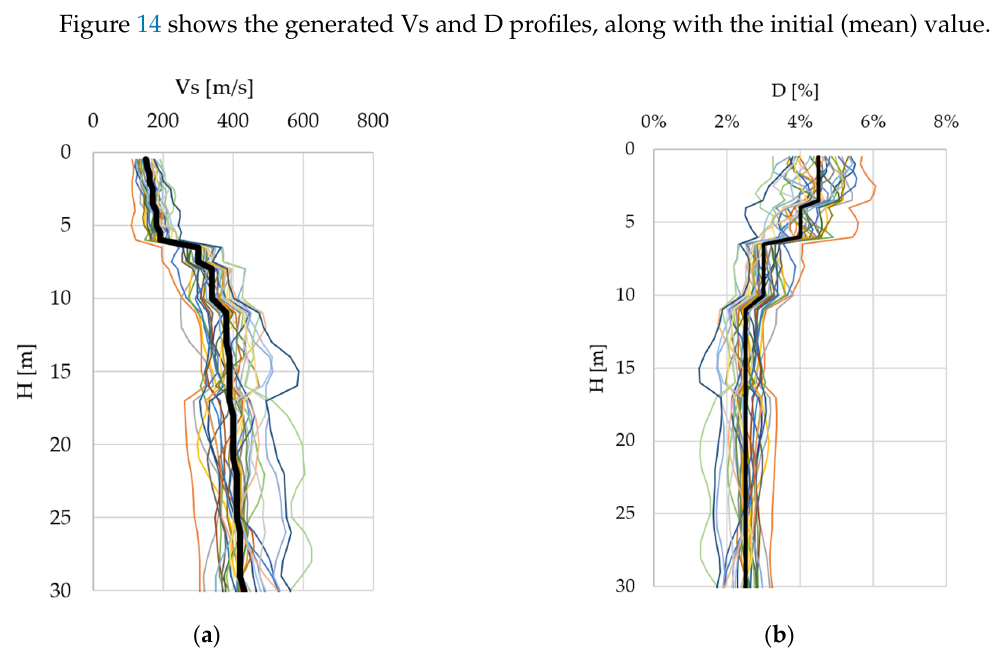
Figure 14. Probabilistic soil properties profiles: ( a ) soil S-wave velocity profile 1; ( b ) soil damping profile. The G- γ and D- γ linear-equivalent soil behavior curves are each generated using a one-dimensional random field, with large correlation lengths (slow variations) [55]. The Seed–Idriss curves (Figure 6) are used as the base (mean) values, along with the parameters from Table 3. Table 3. Probabilistic G- γ and D- γ curve generation parameters [49].